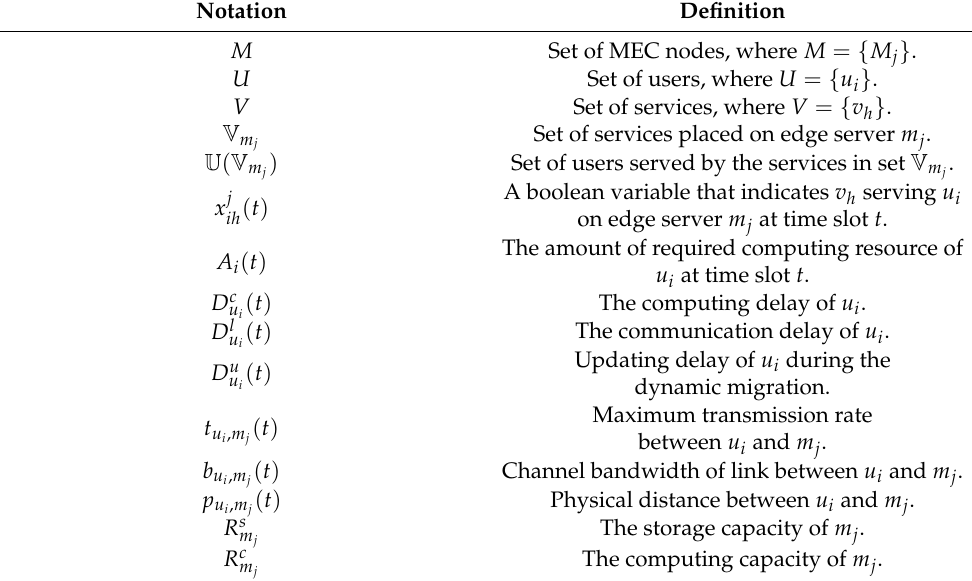
Table 1. List of main